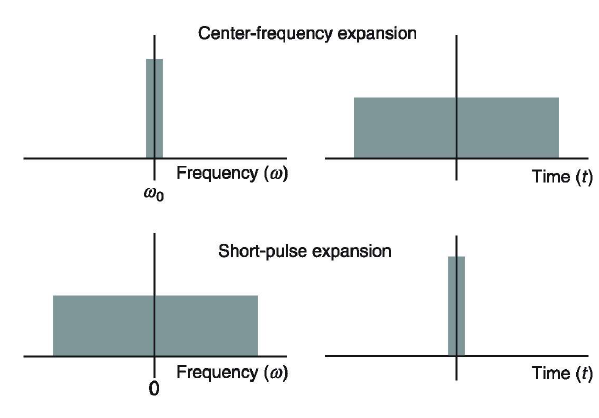
Figure 7: Comparison of the SVEA and SPE. (Adapted from [100]).